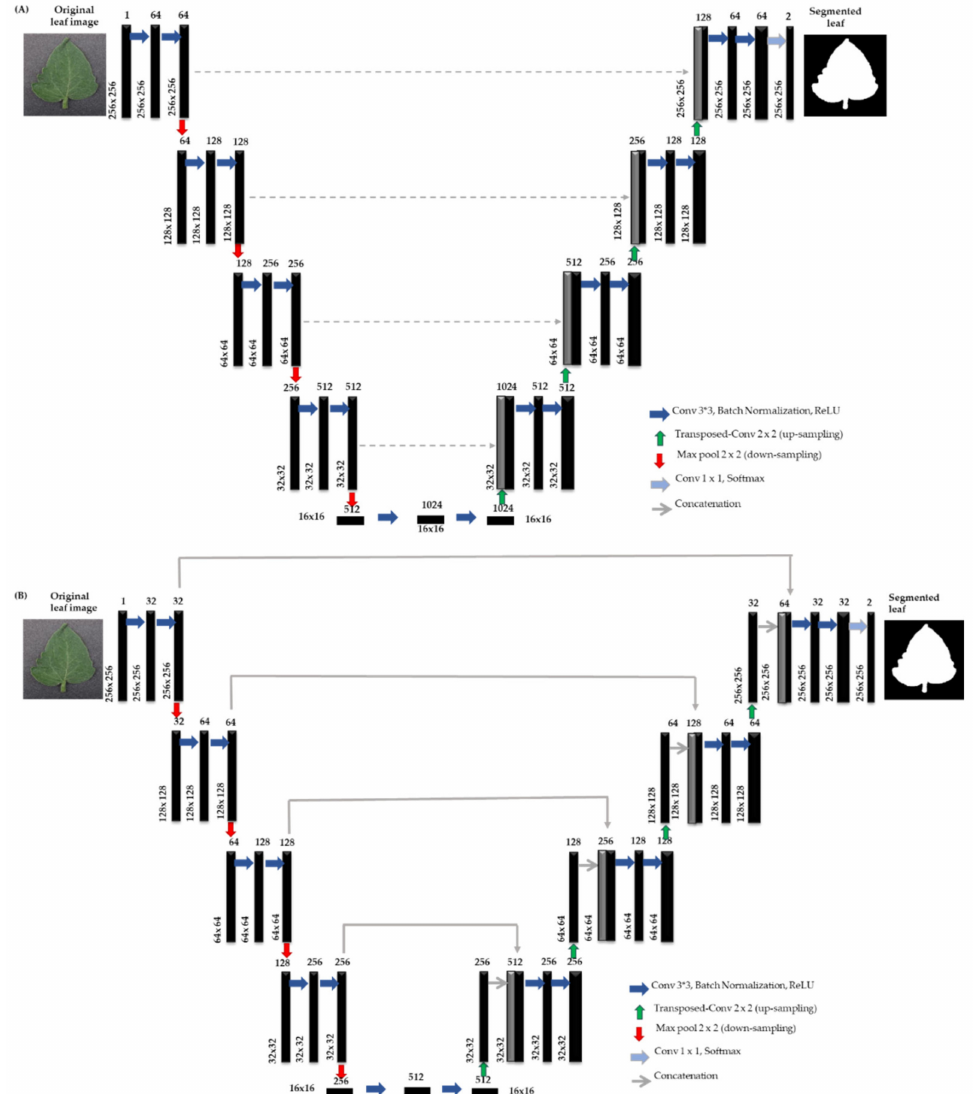
Figure 1. Architecture of ( A ) original U-Net and ( B ) modified